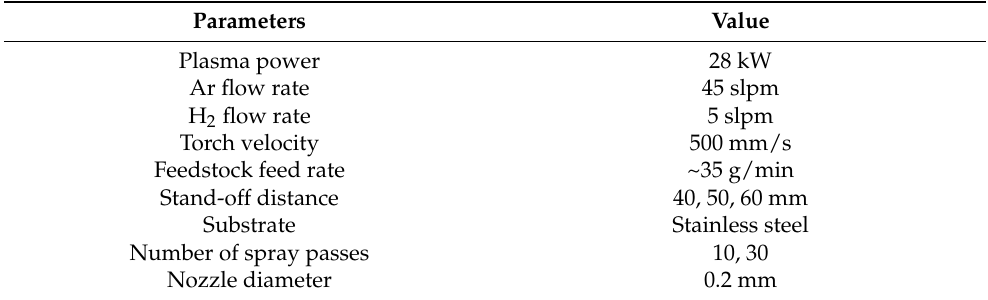
Table 2. Solution precursor plasma spraying parameters for spraying TiO 2